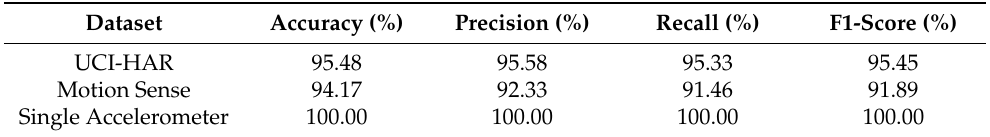
Table 7. Experimental results of the